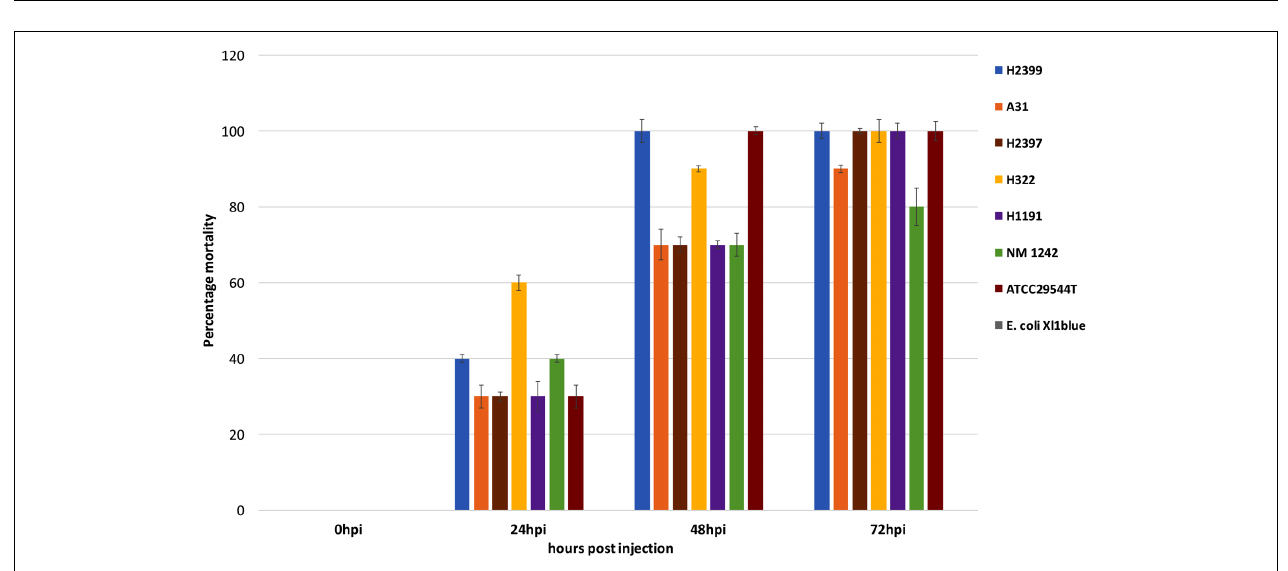
FIGURE 4 | Comparative genomic analysis to identify pCS1-like sequences: Mauve global alignment of the pCS1-like sequences in H322: (track 4) with C. sakazakii NCTC 8155 pCS1_NCTC 8155 (track 1), C. sakazakii pNCIM8272 (track2) and C. sakazakii 8399 pCsak8399 (track 3). H322 contigs mapping to pCS1 plasmid (CP012254) were used to create an artificial molecule to represent pH322 (track 4; pH322_pseudomolecule). This artificial scaffold was compared with pCS1 and pCS1-like plasmid contigs from strains NCIMB8272 (track2) and Csak8399 (track3). In addition to pESA3-like plasmid, isolates such as strain H322 reported in this work contain a large plasmid highly comparable to pCS1